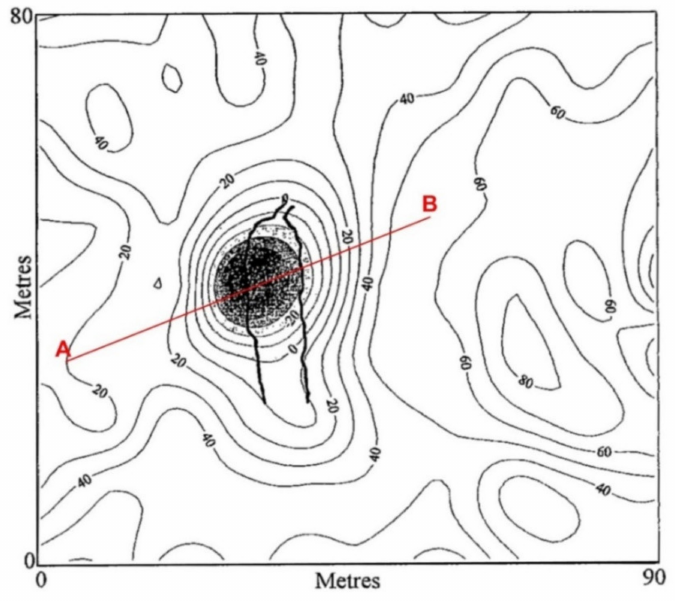
Figure 17. SP map over underground cave and position of interpreting profile A—B (SP map after [25]).